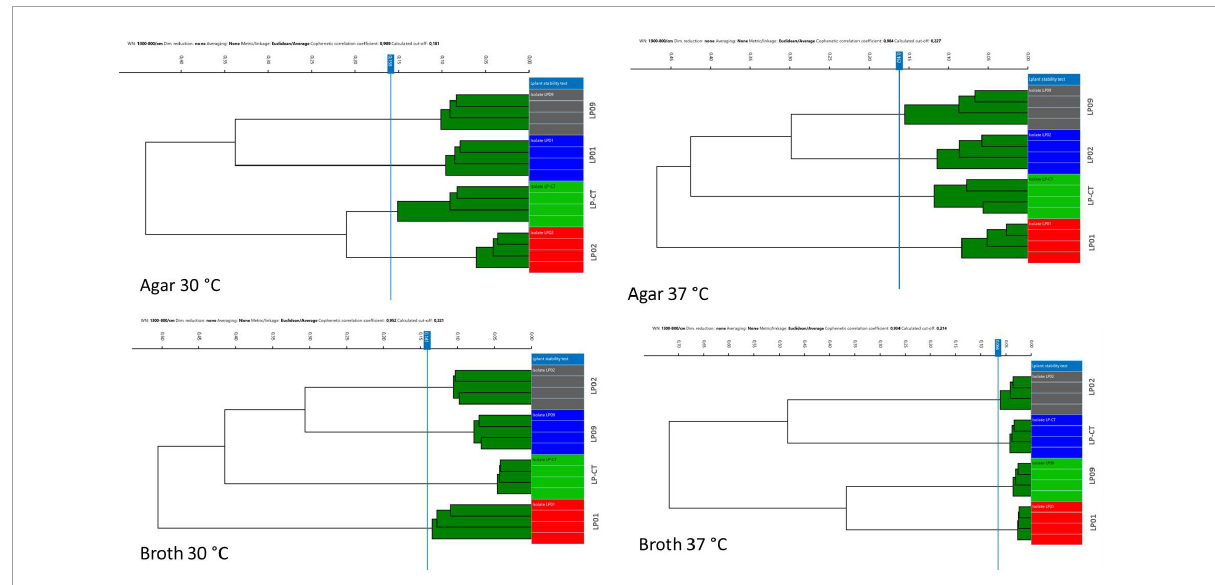
FIGURE2 Hierarchical cluster analysis (HCA) results for the four incubation protocols from experimental scheme 1. Each isolate is represented by its four technical replicates (on the right side of each image), and it is depicted with a different color. On the left side of each image, the IR Biotyper clustering of the spectra into the corresponding isolates is shown, as well as the relationship between the different isolates (indicated by the branches of the dendrogram).